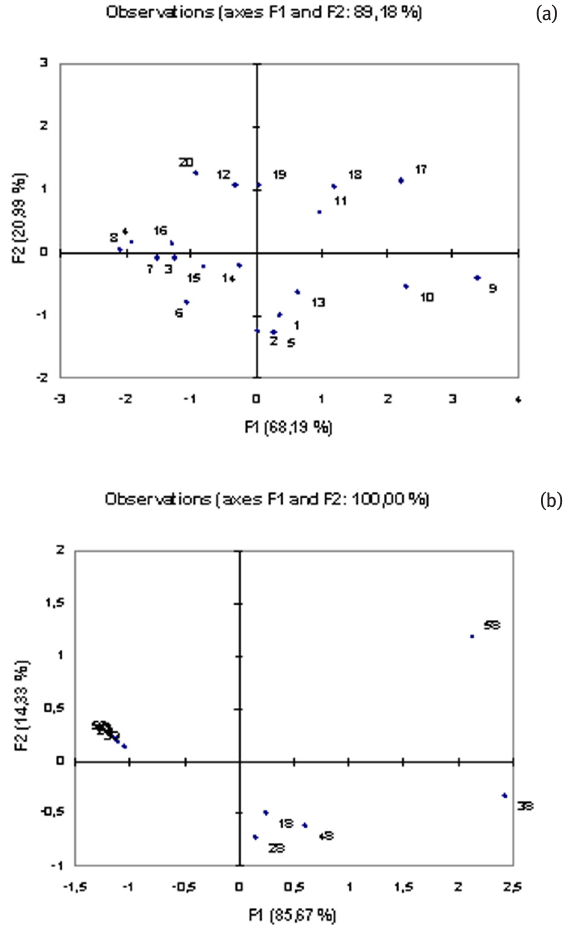
Figure 3: Representation of a) the concentrations in the soil samples depending on the distance from the road of Fe, Pb, and Zn (1 signifies it is the first sample from the Table 2-location (1), distance from the road 0 m, east from the road), generated by the first and second principal components (PCs); b) the concentrations of metals in the soil and grape samples (1S signifies the first sample from the Table 4-location (1), soil), generated by the first and second principal components